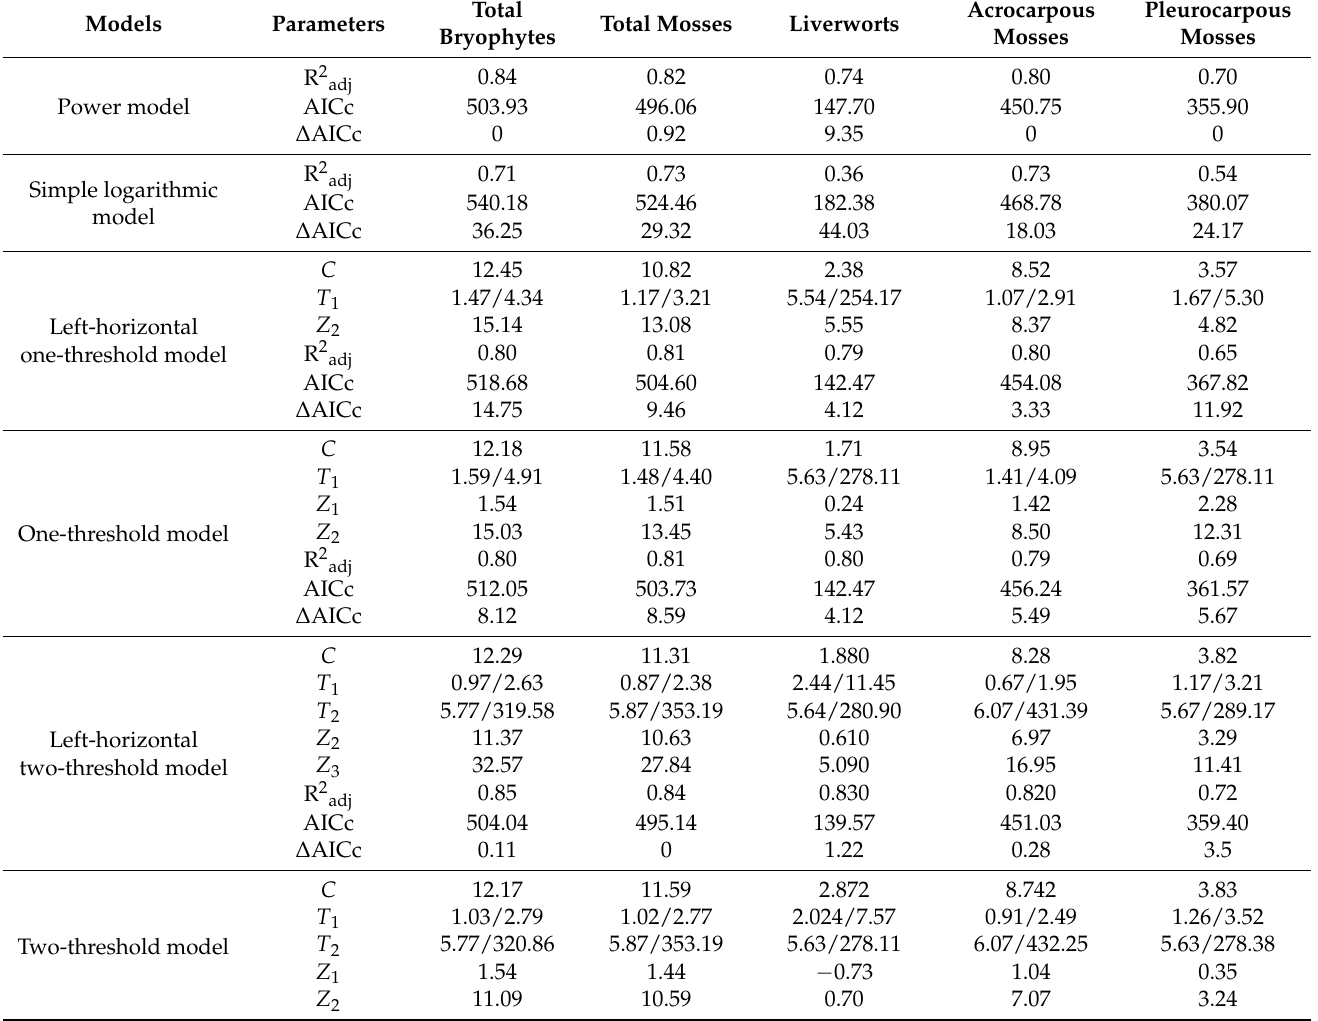
Table 1. Parameters of six SKR models for five bryophyte